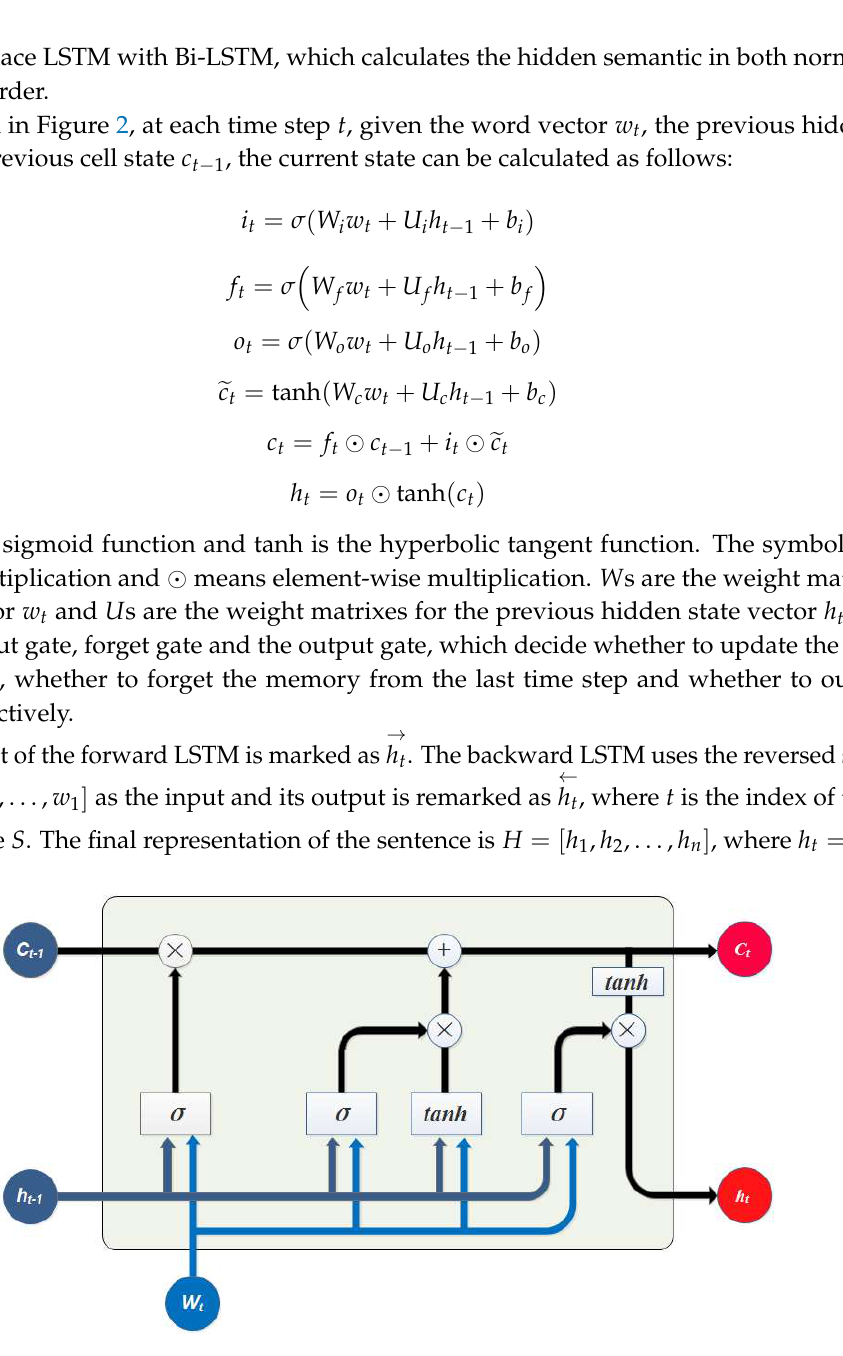
Figure 2. The architecture of LSTM cell used in the AARCNN model.